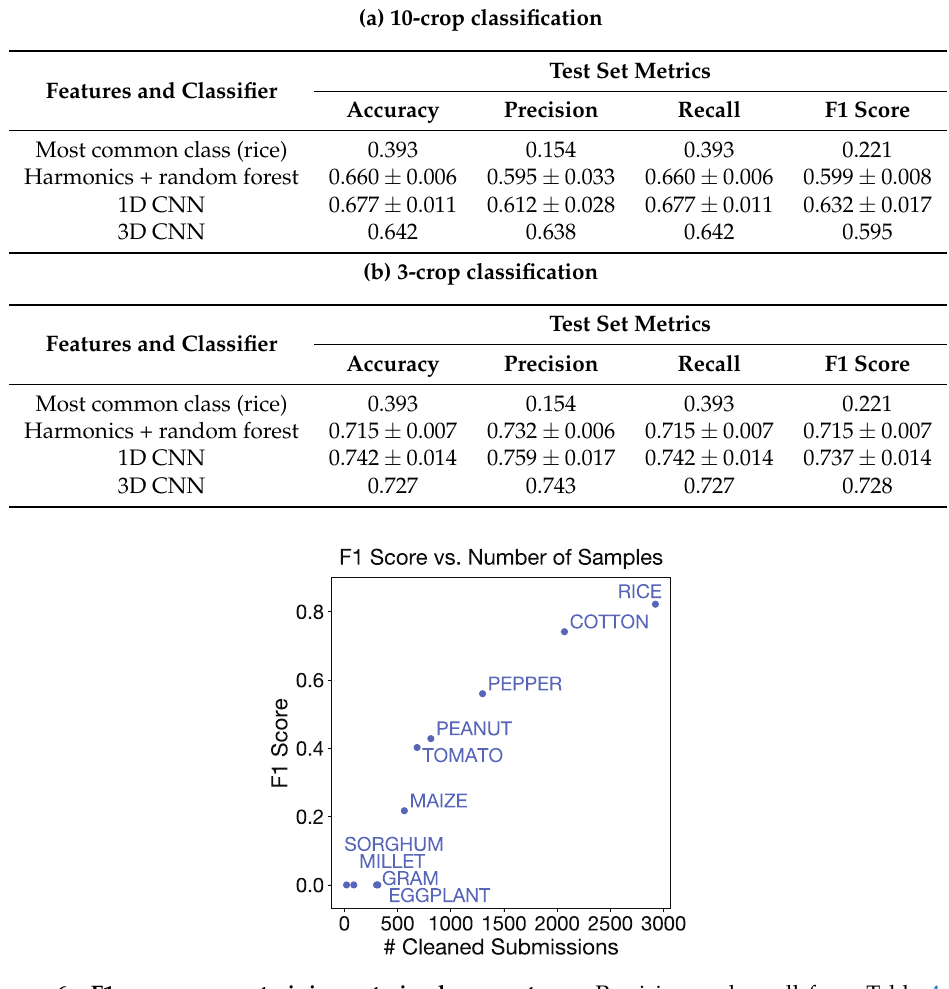
Figure 6. F1 score versus training set size by crop type. Precision and recall from Table 4 are summarized as one F1 score for each crop